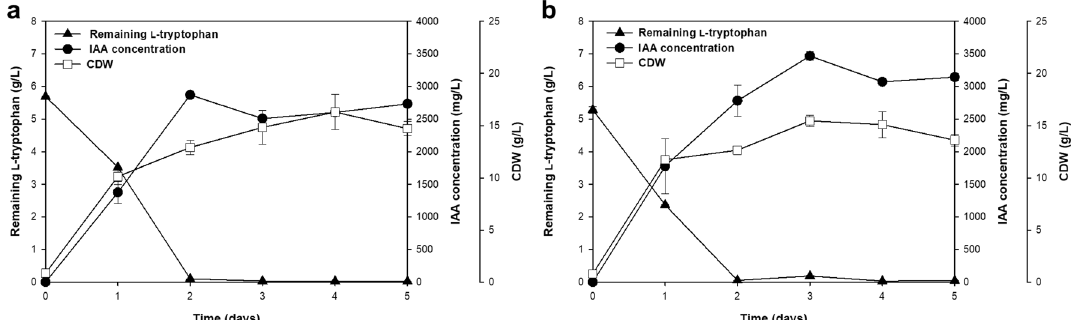
Figure 5. The IAA concentration (mg/L), remaining l-tryptophan and cell dry weight in the batch fermentation of R. fluvialis DMKU-CP293 in ( a ) 2-L and ( b ) 15-L stirred tank bioreactors using the optimal